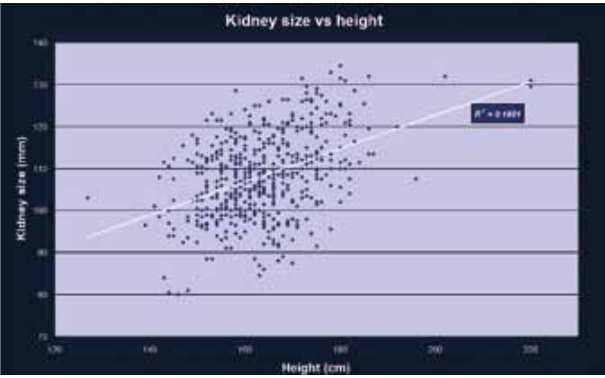
Fig. 4. Kidney size in relation to body